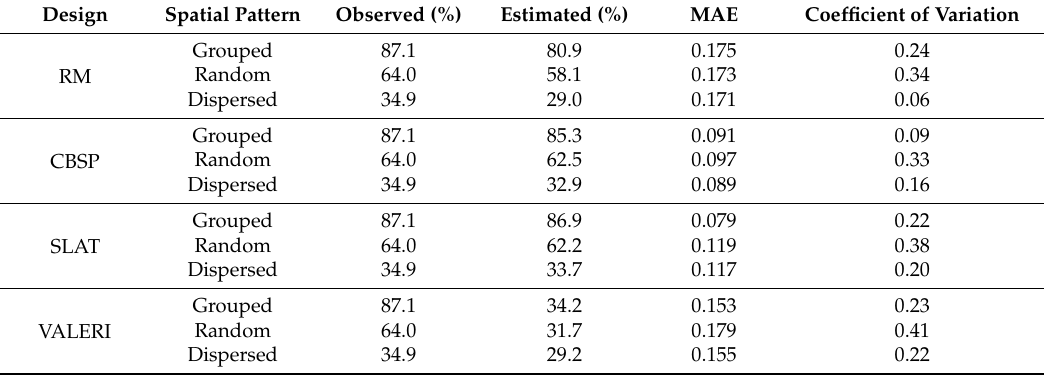
Table 1. Estimated and observed cover values (%) per type of sampling and spatial pattern of trees.